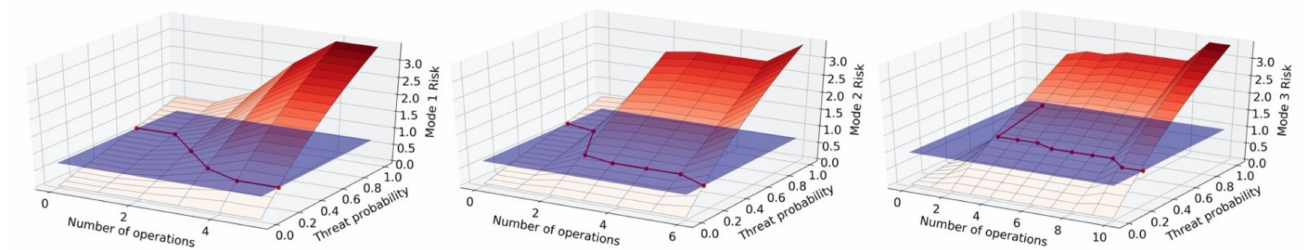
Figure 9. Surface plots of the sensitivity analysis of number of operations vs. threat probability vs. mode risk. Mode 1, mode 2, and mode 3 of the smart connected insulin pump are illustrated. The heat map surface shows the security threat zone that requires risk mitigation by mode